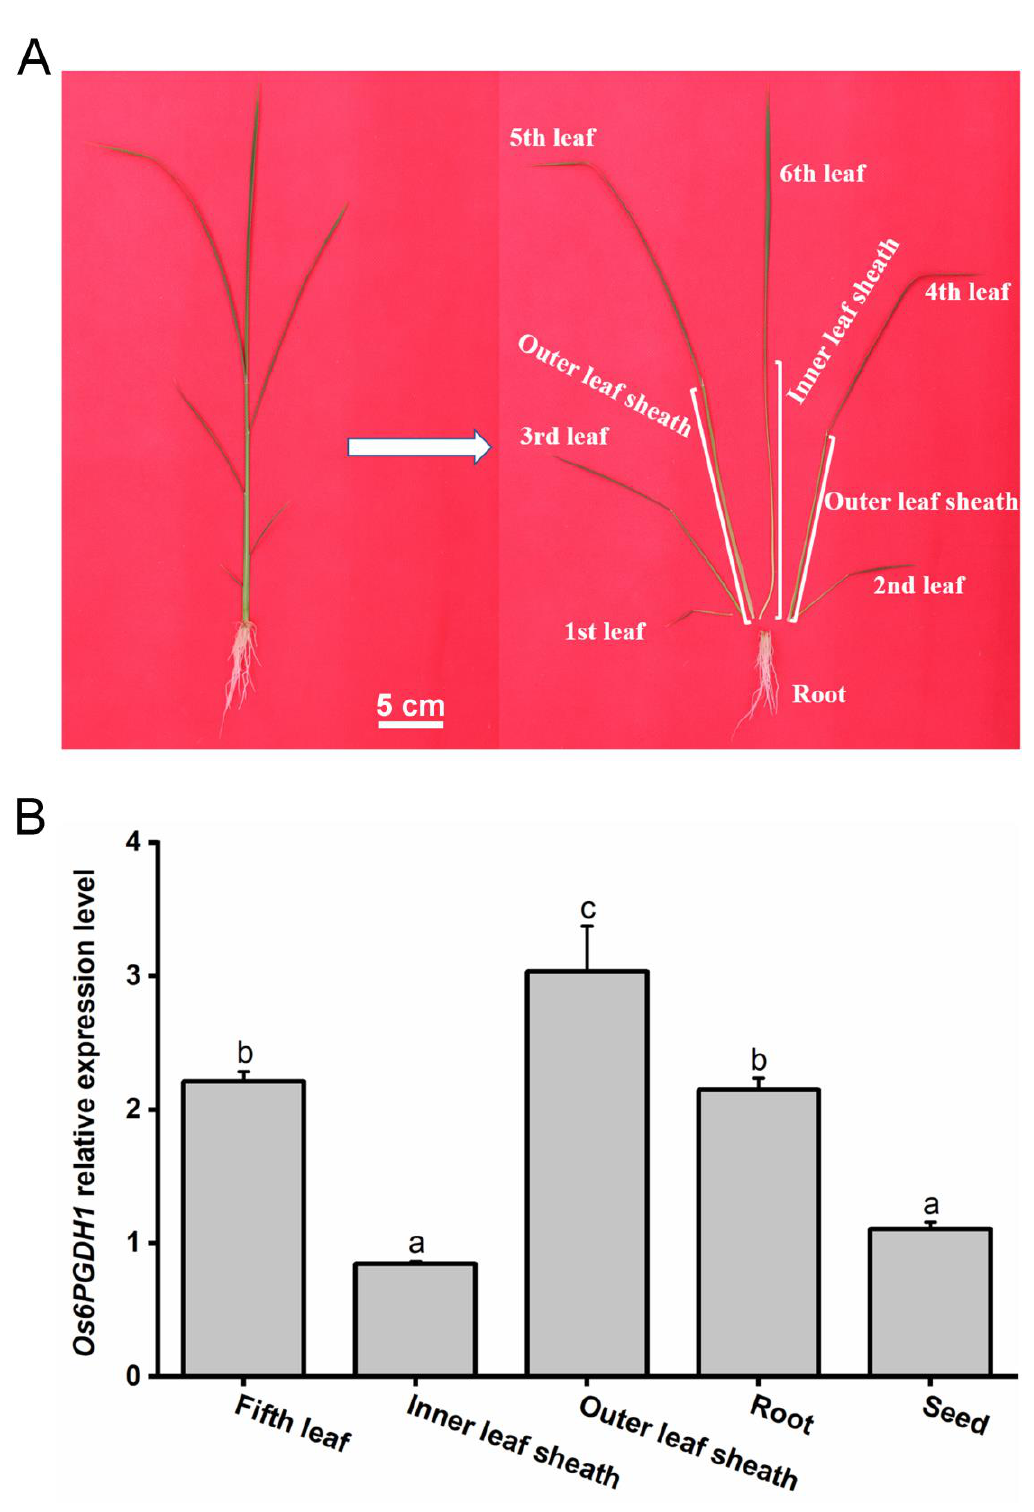
Figure 2. Expression profile of Os6PGDH1 gene in various tissues of rice. ( A ) Schematic of a 30-day-old seedling with a fully expanded fifth leaf. Samples were collected from the fifth fully expanded leaves, inner leaf sheaths, outer leaf sheaths, roots (tissues indicated), and seeds of rice variety Xiushui 110, and used for RNA extraction and quantitative real-time PCR (qRT-PCR) analysis. ( B ) Relative transcript levels of Os6PGDH1 in di ff erent tissues of rice. Values are means + SE, n = 6. Di ff erent letters indicate significant di ff erences among tissues (one-way ANOVA followed by Duncan’s multiple range test, p < 0.05).